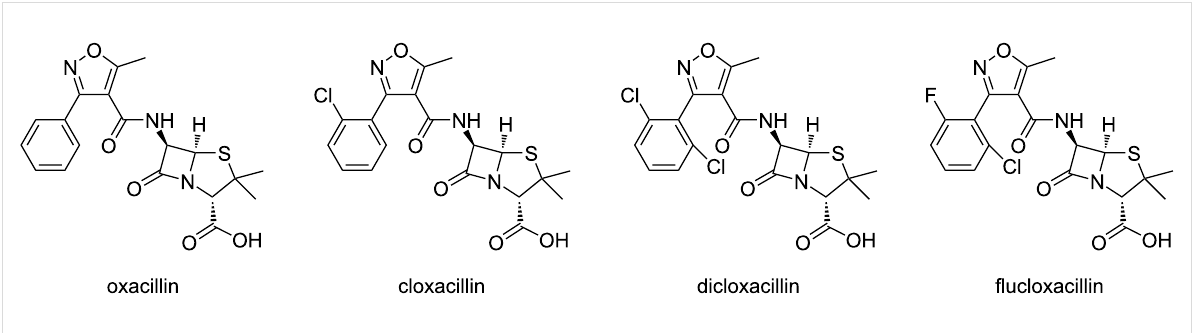
Figure 9: Structures of β -lactamase-resistant antibiotics oxacillin, cloxacillin, dicloxacillin, and